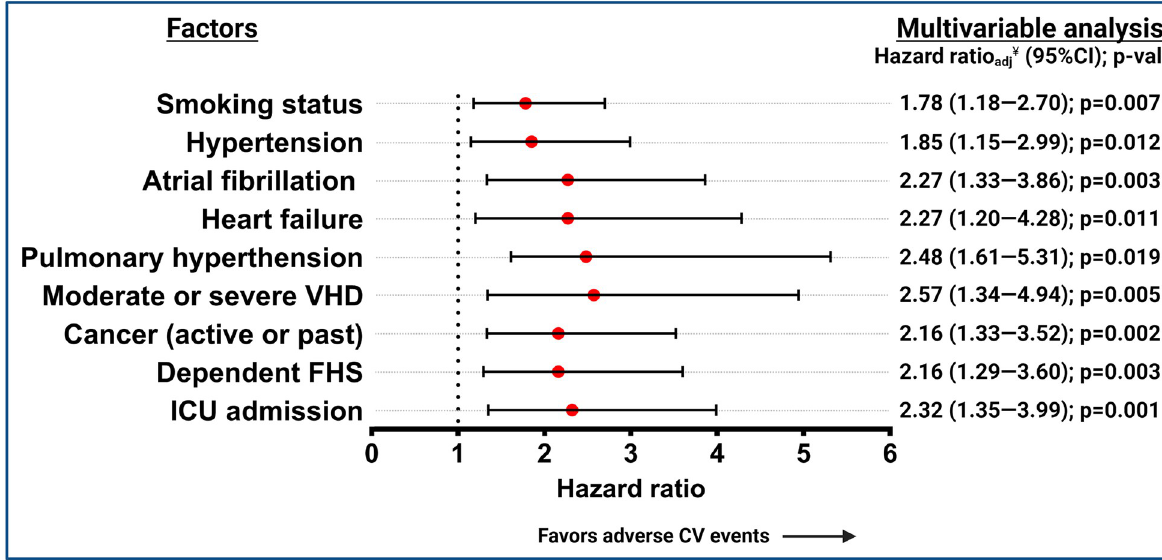
Fig 4. Multivariable predictors of adverse cardiovascular events during the post-acute phase in patients with COVID-19. Adverse cardiovascular events are defined as the composite of cardiovascular death, any venous or arterial thrombotic event, heart failure hospitalization, or any serious arrhythmia. Post-acute phase comprised from 31–365 days of follow-up. ¥ Cox proportional hazards regression analysis adjusted by the significant variables in univariate analysis using a backward selection model. 95%CI, 95% confidence interval; VHD, valvular heart disease; drugs; ICU: intensive care unit; FHS, functional health